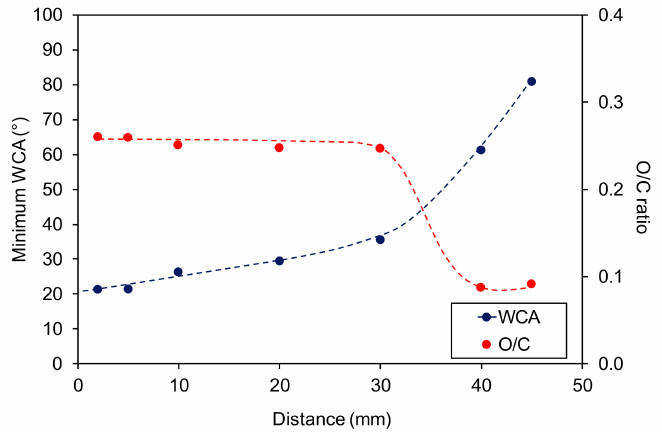
Figure 8. The correlation between the minimum apparent water contact angle and O / C